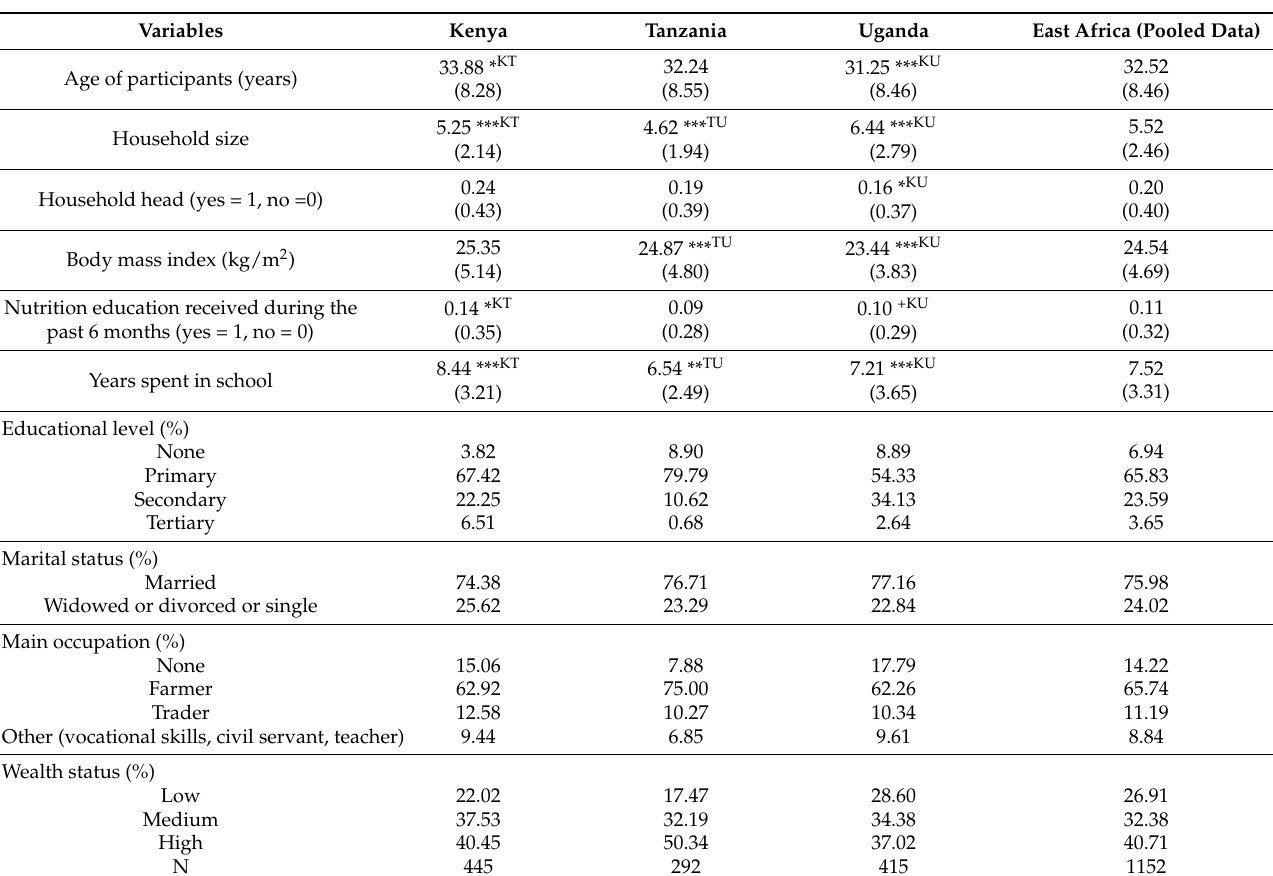
Table 2. Socio-economic and demographic statistics of women of reproductive age in Kenya, Tanzania, Uganda, and East Africa. Variables Kenya Tanzania Uganda East Africa (Pooled Data) Age of participants